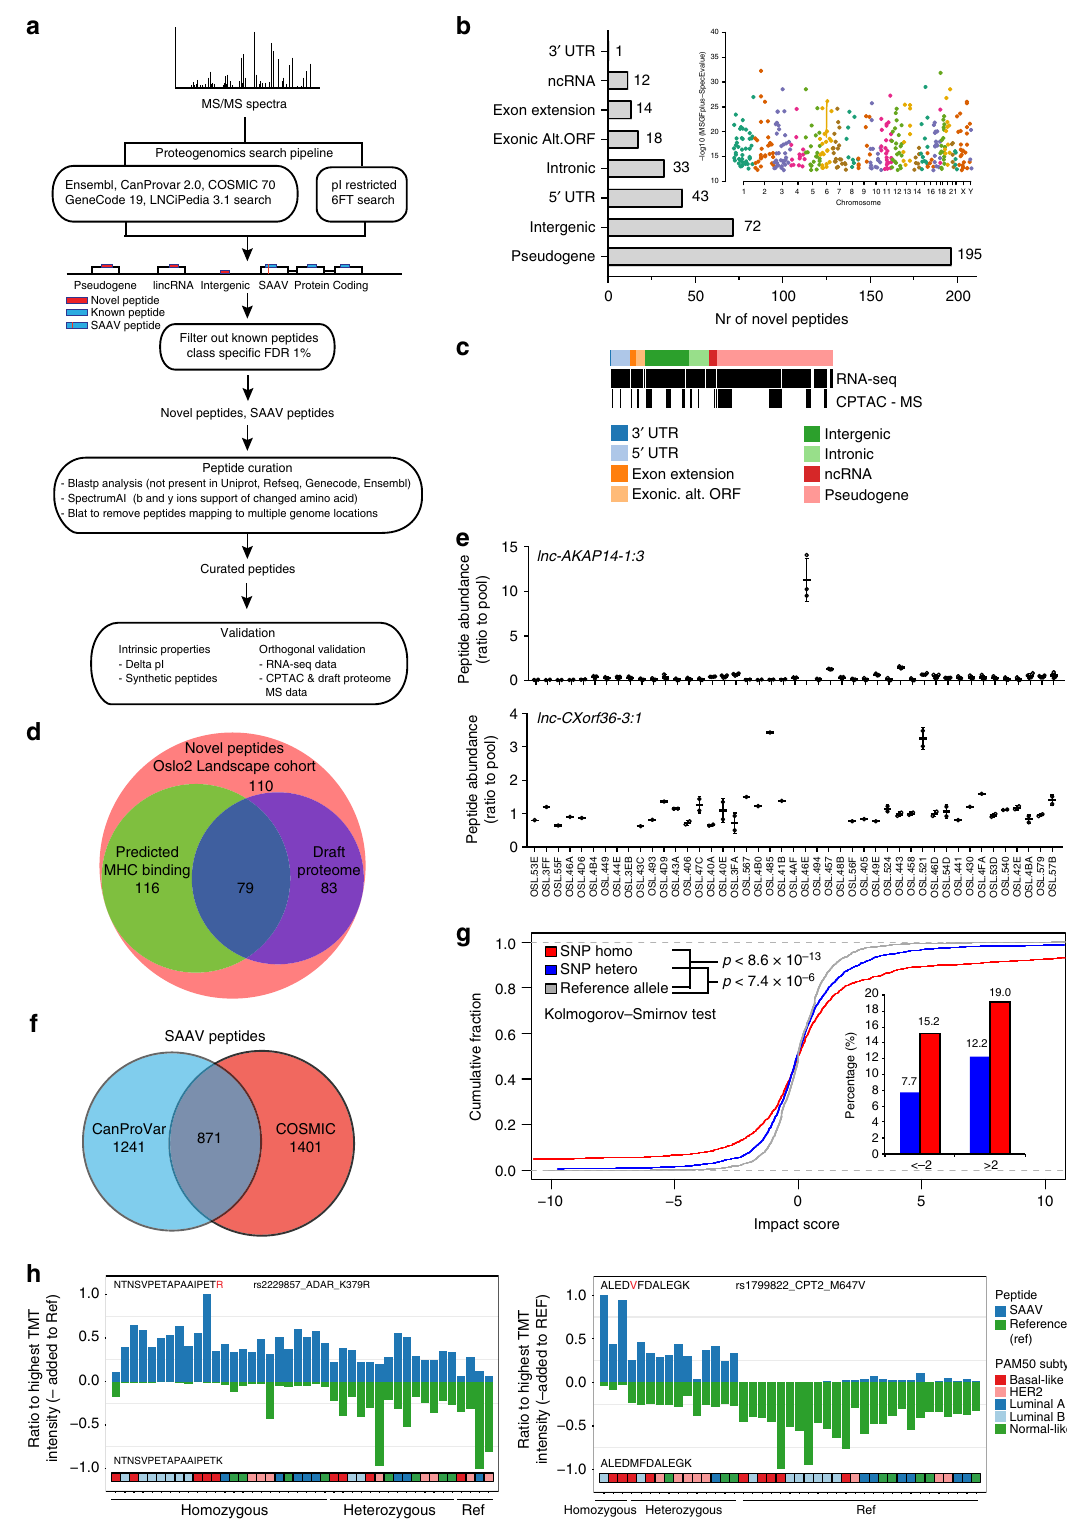
un-annotated alternative gene translations (exon extensions, 3 ′ genomic loci are supported by mappings of at least two peptides and 5 ′ UTRs, exonic alternate open-reading frames) (Fig. 7b, (Supplementary Fig. 14C). Additionally, RNAseq measurements Supplementary Data 6); two-thirds of which are identi fi ed by at and proteomic MS-spectra 5,33 verify that many of these peptides are transcribed and translated in independent breast tumor least two PSMs (Supplementary Fig. 14A). Furthermore, these cohorts (Fig. 7c, Supplementary Fig. 14D), while CAGE 34 and peptides have a similar pI distribution as known peptides ribosomal pro fi ling 35 reveal they are transcribed and translated in (Supplementary Fig. 14B), and 10% of the corresponding coding NATURE COMMUNICATIONS| (2019) 10:1600